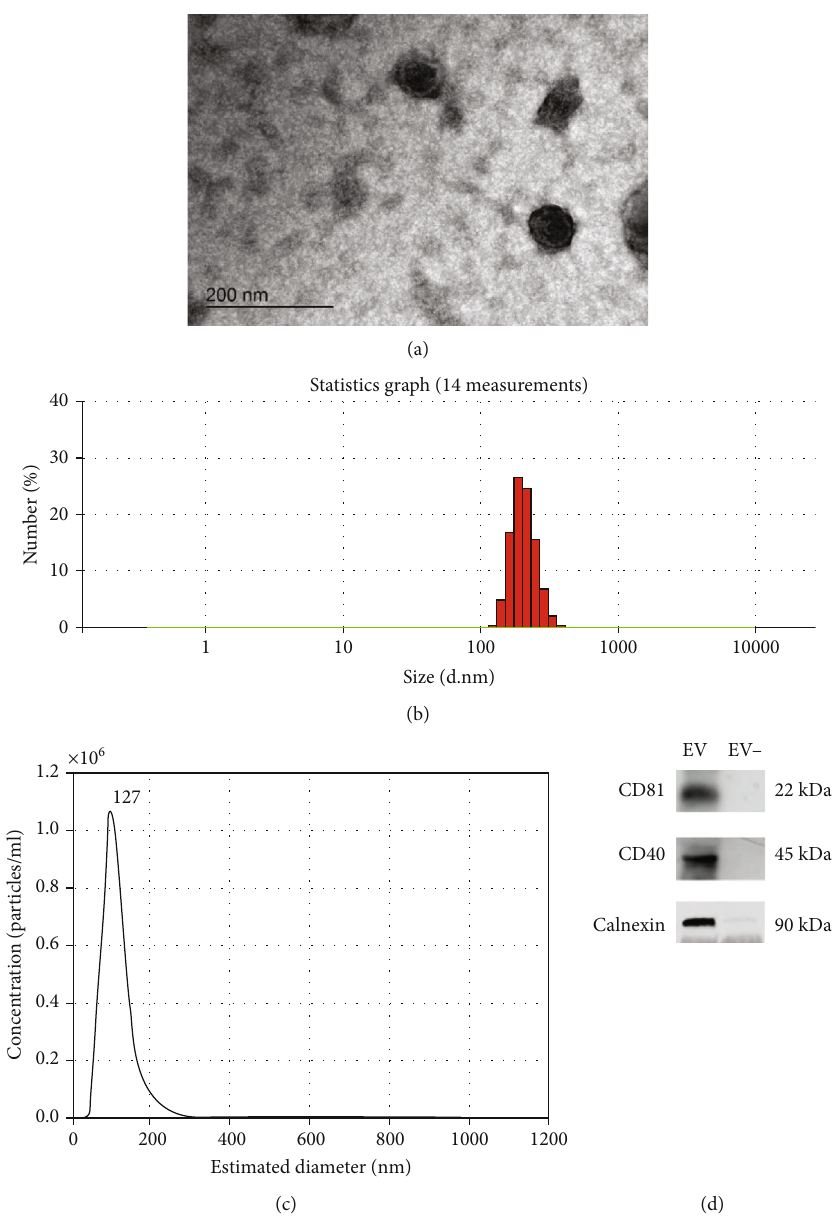
Figure 2: Characterization of adipose stem cell- (ASC-) derived extracellular vesicles (EVs). (a) Transmission electron microscopy of ASC- derived EVs showed a spherical shape and lipid bilayers (original magni fi cation × 250,000; the scale bar indicates 200 nm). (b) Average size of the EVs calculated by dynamic light scattering was 211 : 7 ± 26 : 6nm , and average concentration was 57,946,000 ± 12,519,069 particles/ml. (c) Nanoparticle tracking analysis revealed corresponding EV size distribution and a mode of 127 : 1 ± 3 : 2nm . (d) Western blotting of EVs showed high expression of CD81, CD40, and